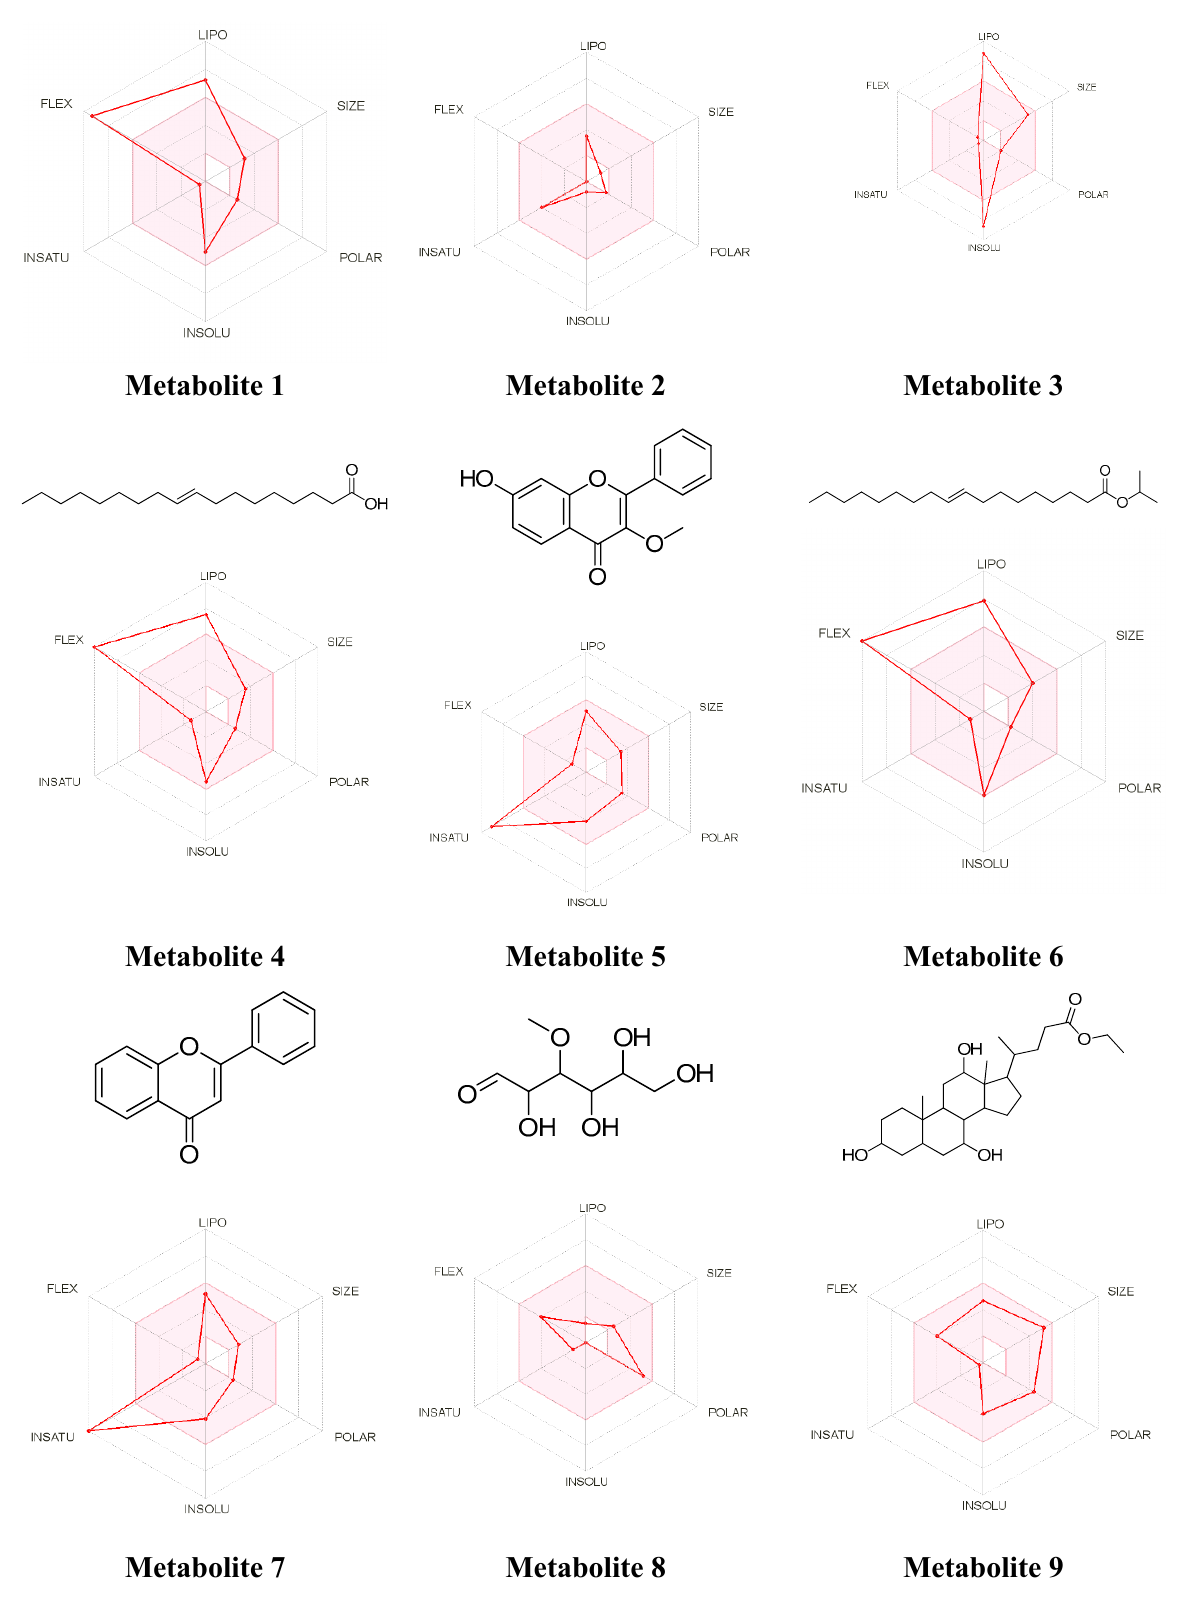
Figure 7. The bioavailability radar for the identified bioactive Metabolites in BERM . LIPO: Lipophilicity, Size: Molecular weight, POLAR: solubility, INSOLU: insolubility, INSATU: insaturation, and FLEX: flexibility. The properties within the colored zone are preferred for orally active drugs.